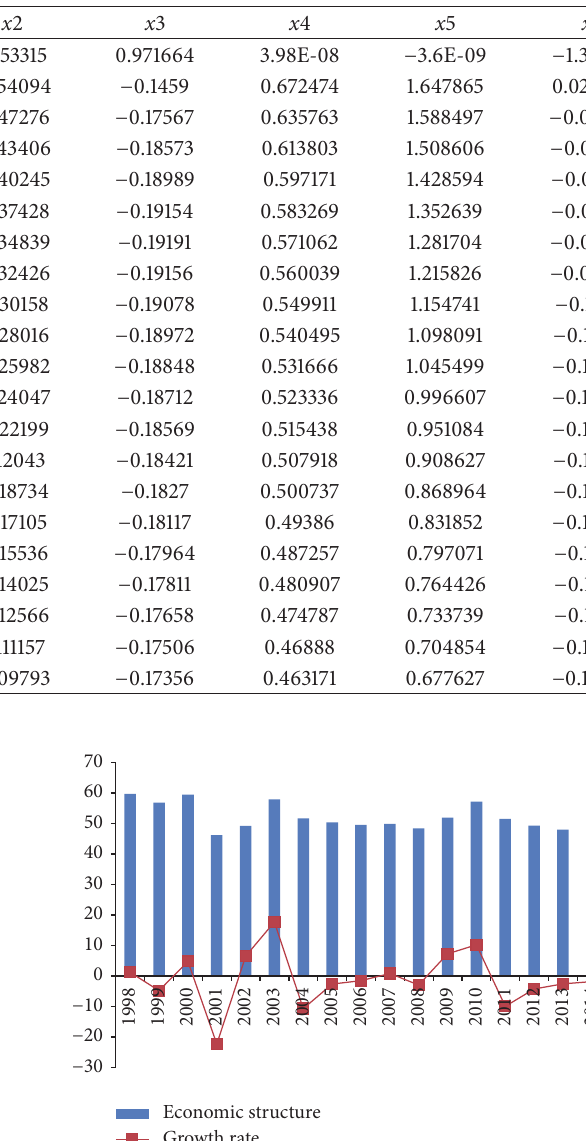
Table 2: The coefficients for estimated values of ridge 𝑘 .